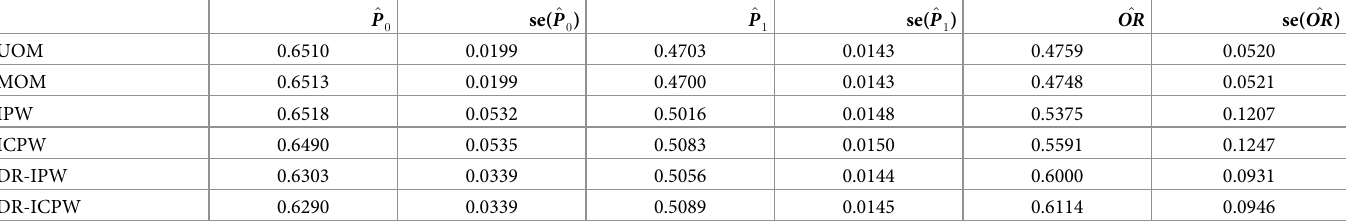
Table 4. The result of six approaches to estimate the effect of prior exposure to Bovine Viral Diarrhea Virus (BVDV) on Bovine Respiratory Disease (BRD) inci- dence using a subset of the NBRDI data with 1,552 cattle nested in 10